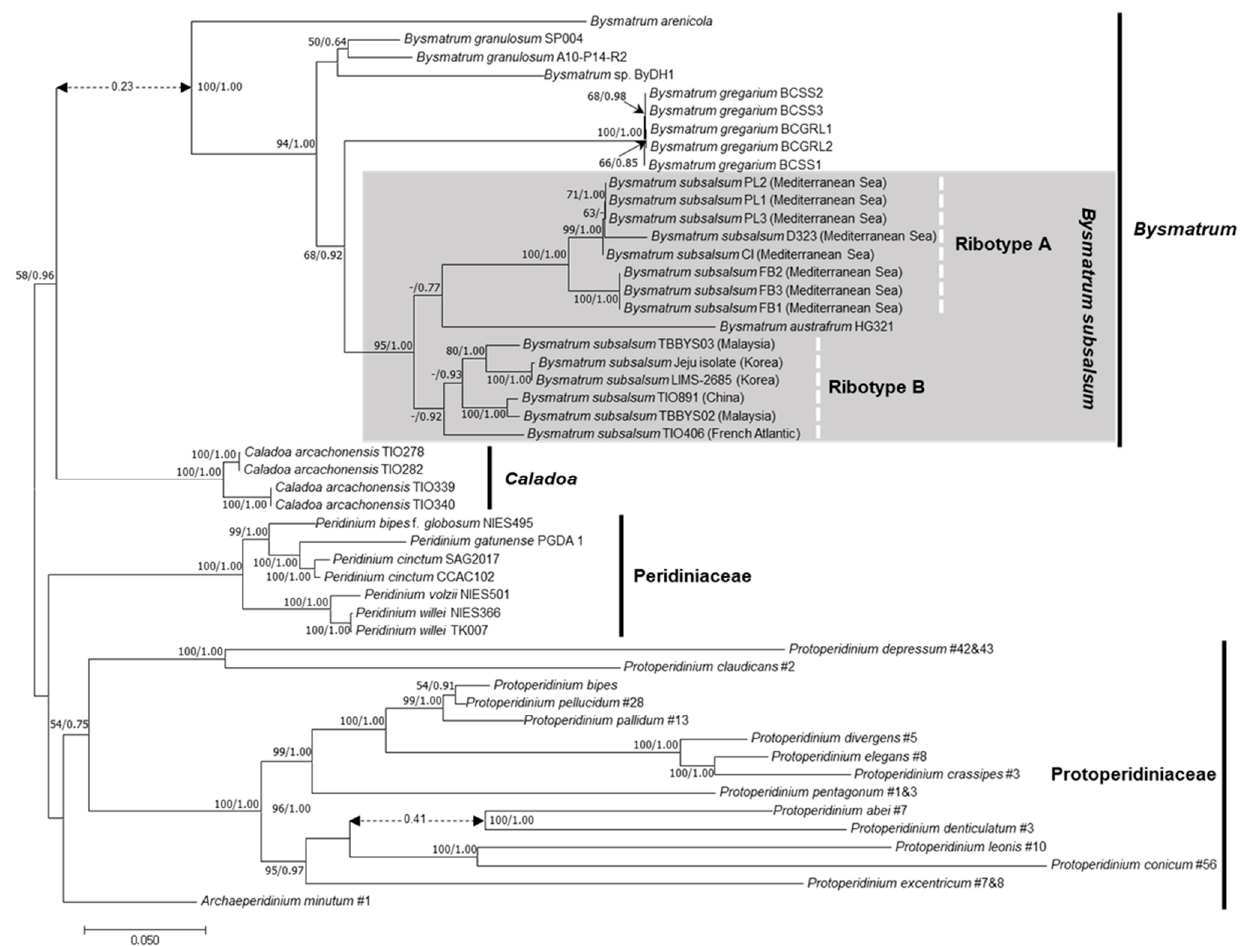
Figure 4. Phylogeny of Bysmatrum subsalsum inferred from concatenated SSU and partial LSU rRNA gene sequences using maximum-likelihood (ML). Ribotypes are labeled according to designations by Luo et al. [8]. Numbers on branches are statistical support values to clusters on the right of them (left: ML bootstrap support (BT) values; right: Bayesian posterior probabilities (PP)). Bootstrap support values > 50% and Bayesian posterior probabilities > 0.7 are shown. Branch lengths are drawn to scale, with the scale bar indicating the number of nucleotide substitutions per site.